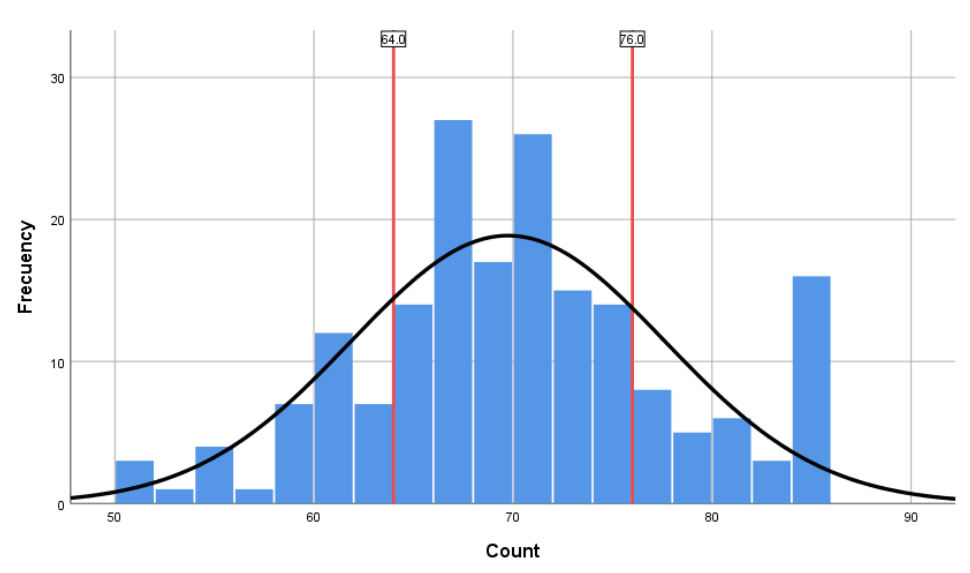
Figure 5. Frequency distribution of the “Level of Sustainability” variable and overprinted normal distribution curve. Note. The lower (64) and upper (76) cut-off values for the determination of class categories are represented.